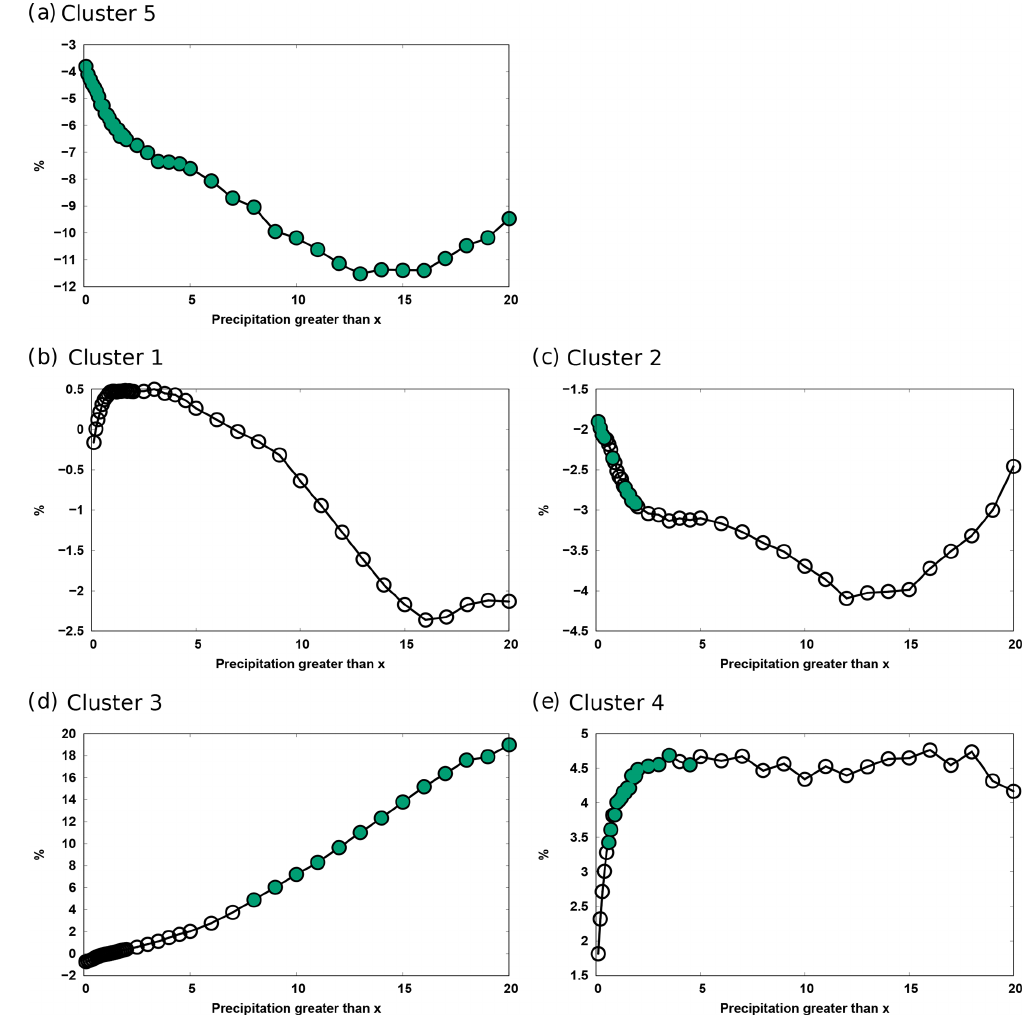
Figure 7. Series of relative differences between ARCI and BASE based on different thresholds in rainy days for the different regions (Fig. 6). Green circles denote the thresholds for which the differences are significant ( p value <